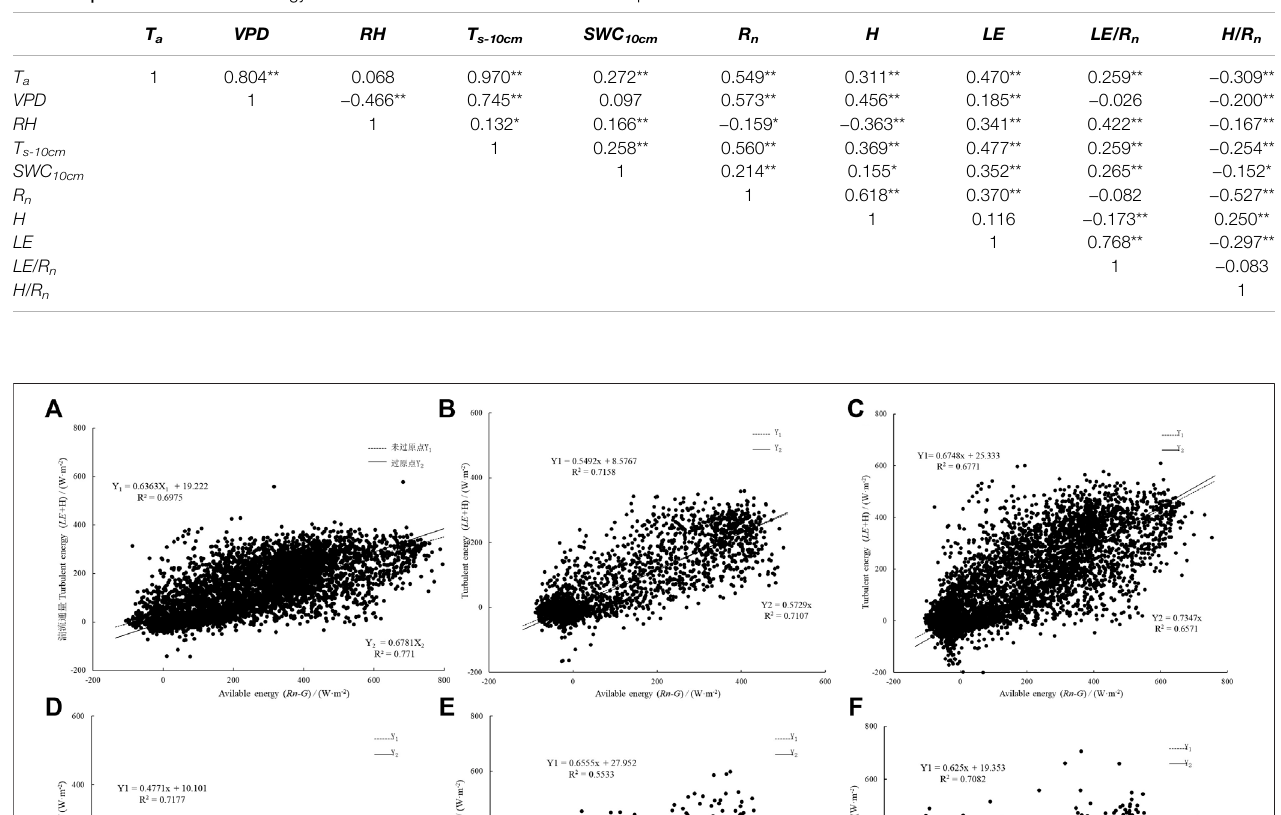
Frontiers in Environmental Science |